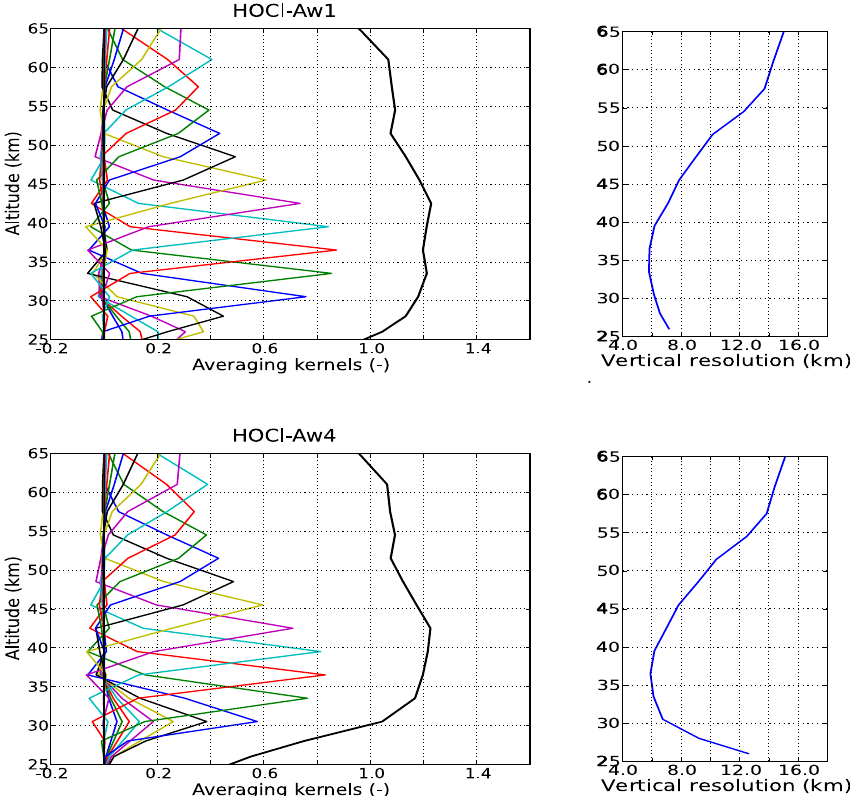
Fig. 14. Same as Fig. 8 but for the HOCl profile retrieved from windows A/B-w1 (upper row) and A-w4 or B-w3 (lower row).